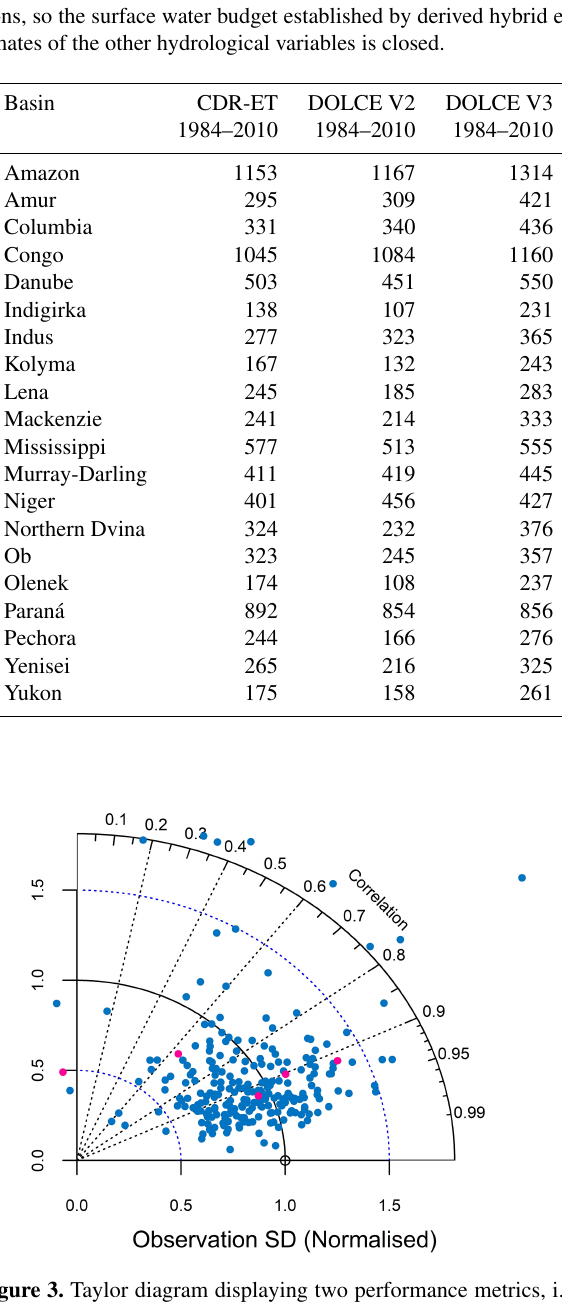
Figure 3. Taylor diagram displaying two performance metrics, i.e. correlation and standard deviation of DOLCE V2 relative to nor- malised observational data presented by a hollow point (reference point) at one unit on the x axis. Pink points represent performance statistics scored at sites located on wetlands, flooded plain or inten- sively irrigated